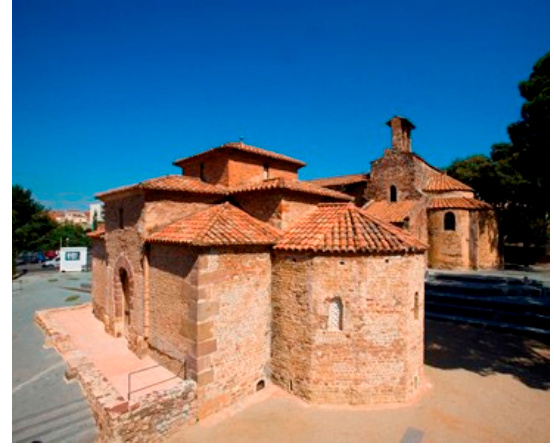
Figure 3. Church of Sant Miquel (Terrassa). © Teresa Llordés (with kind permission).